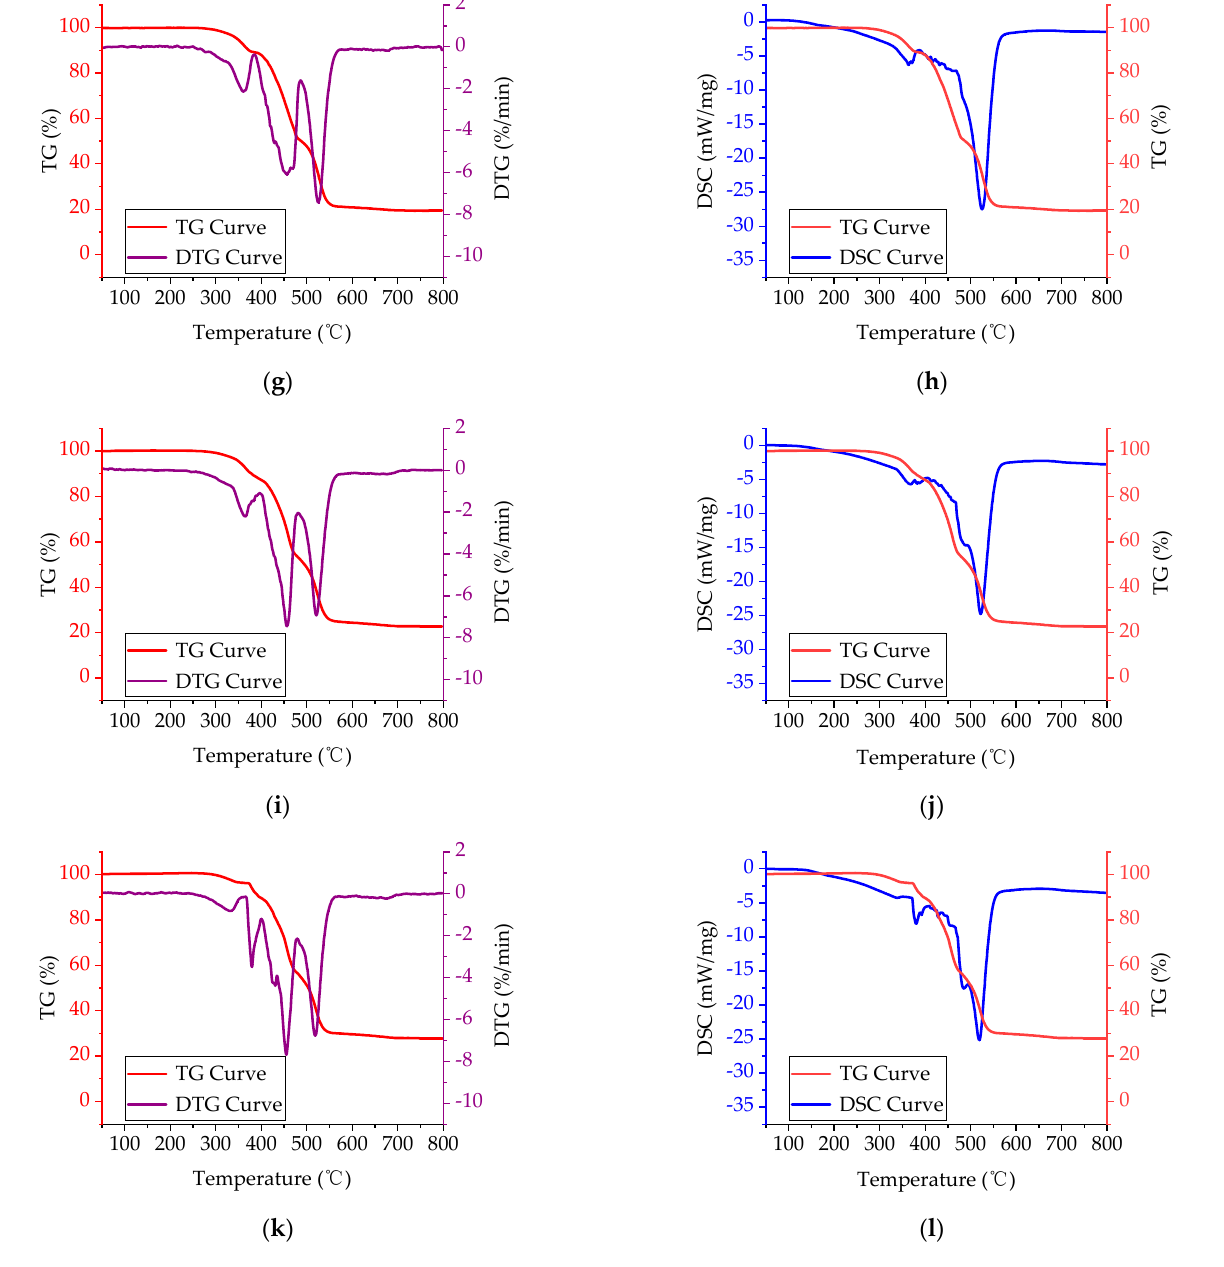
Figure 4. Thermal analysis curves of FRA: ( a ) TG-DTG curve for pure asphalt binder; ( b ) TG-DSC curve for pure asphalt binder; ( c ) TG-DTG curve for 10% FRA; ( d ) TG-DSC curve for 10% FRA; ( e ) TG-DTG curve for 20% FRA; ( f ) TG-DSC curve for 20% FRA; ( g ) TG-DTG curve for 30% FRA; ( h ) TG-DSC curve for 30% FRA; ( i ) TG-DTG curve for 40% FRA; ( j ) TG-DSC curve for 40% FRA; ( k ) TG-DTG curve for 50% FRA; ( l ) TG-DSC curve for 50% FRA.